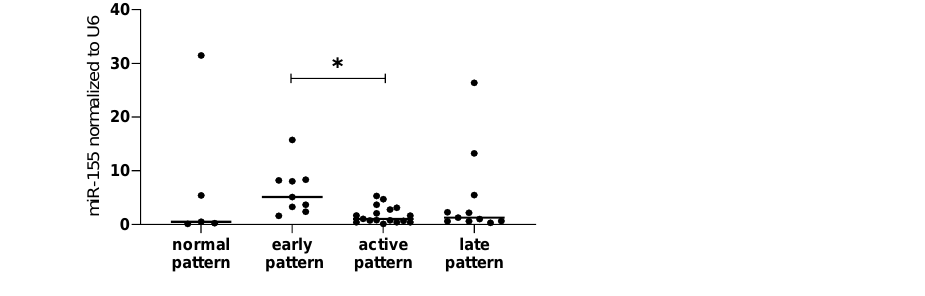
Figure 3. miR-155 expression level in systemic sclerosis patients with different capillaroscopy patterns. Data are presented with the median as scatterplot; * p < 0.05.